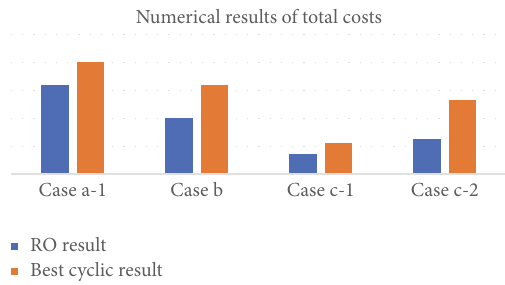
Figure 11: Total costs for different results in different